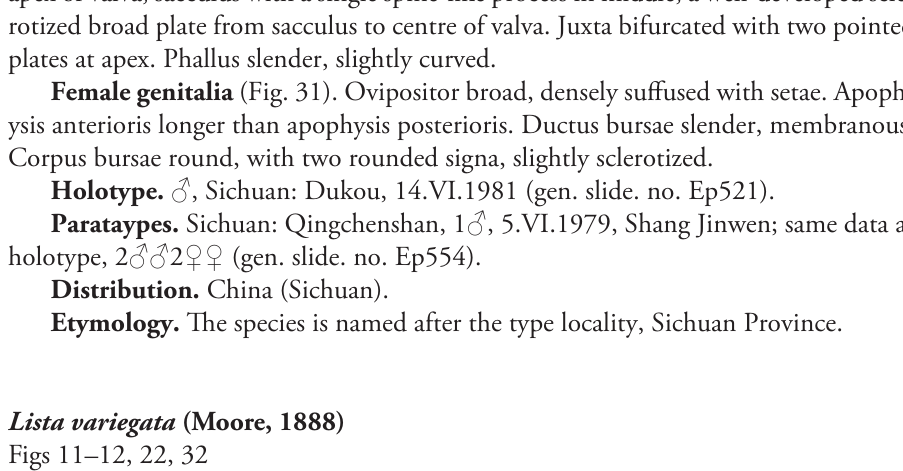
Lista variegata (Moore): Solis 1992: 283. Diagnosis. The species differs from others by the hindwing with pale yellow scales. In the male genitalia, the center of the uncus has two spines, and the phallus is about half as long as